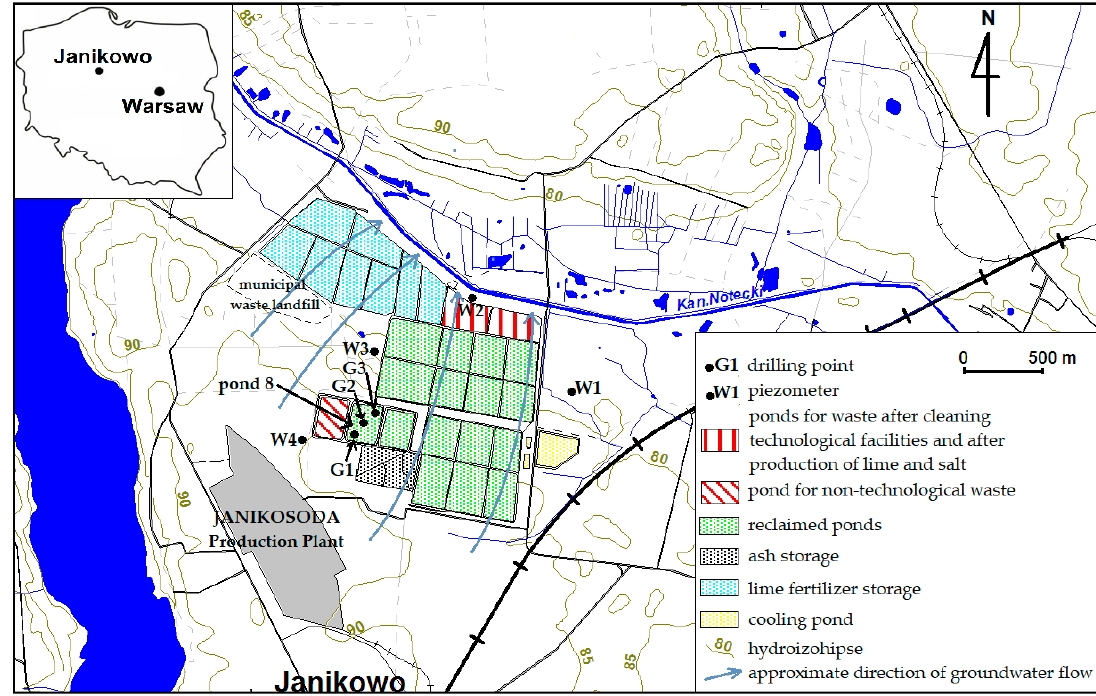
Figure 1. Location of sedimentary ponds (G1–G3 are the waste sampling points, and W1–W4 are the underground water sampling points). Source: own study .